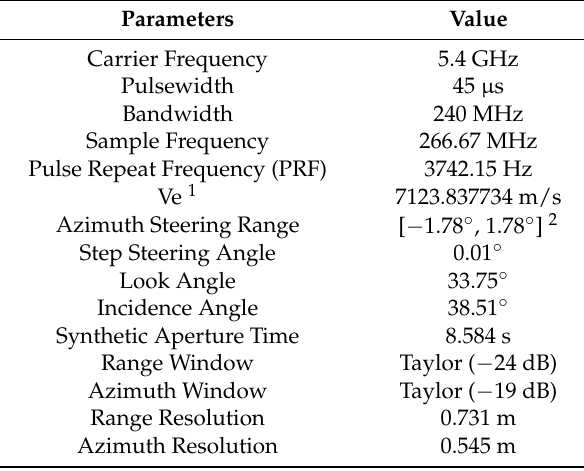
Table 3. Some parameters of an image in ST mode.